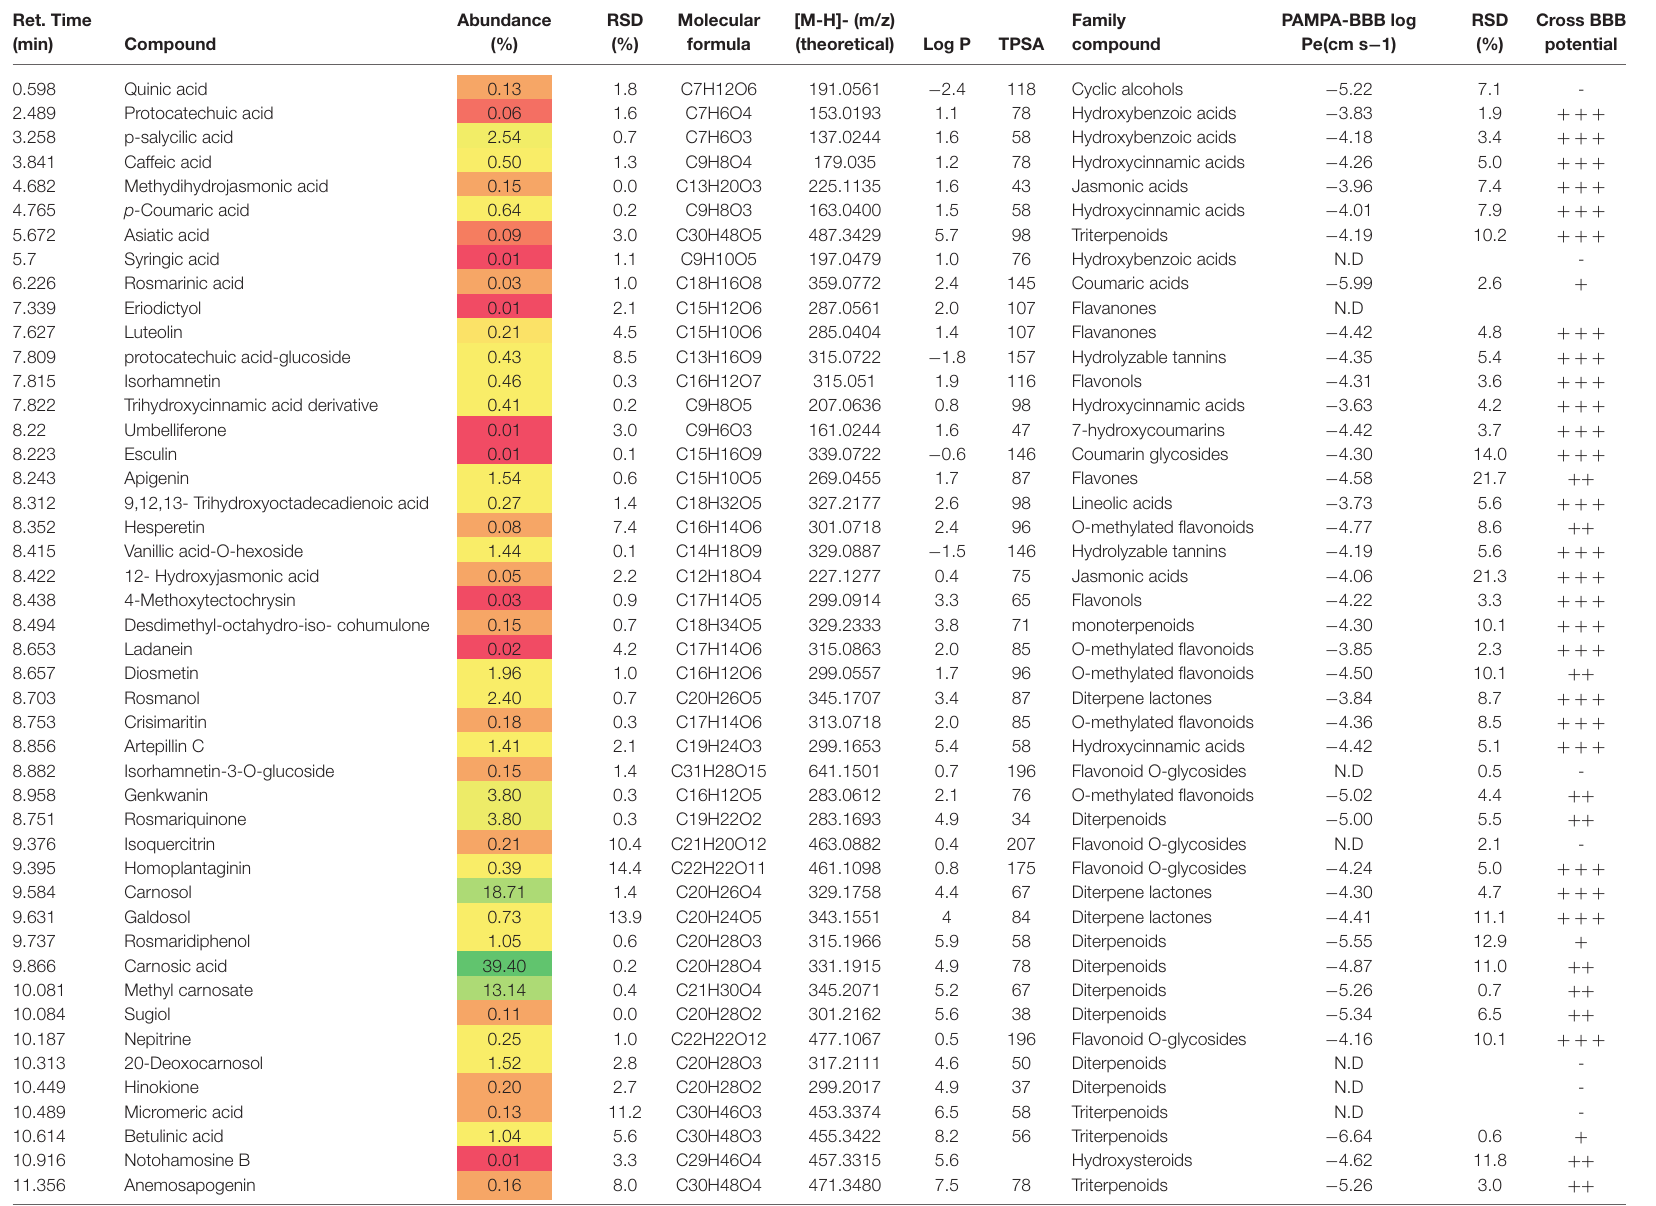
TABLE 1 | Phytochemical profile, abundance (%), and BBB permeability of RSFE (Rosmarinus officinalis L., SFE extract). Ret.